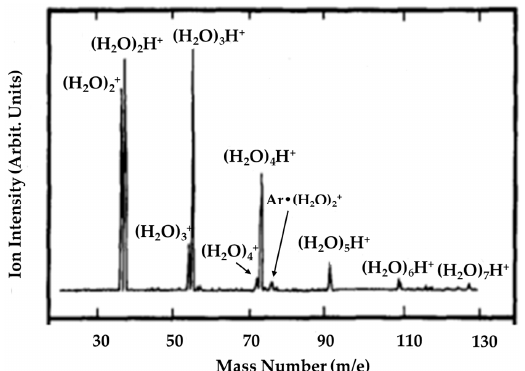
Figure 10. Vacuum-UV photoionization mass spectrum of water clusters at 11.83 and 11.62 eV (Ar resonance lamp; LiF window) with unit mass resolution. Condition: 3.0 atm stagnation pressure and 200 accumulations. Figure adapted from [10] with permission. Copyright 1986 American Institute of Physics.